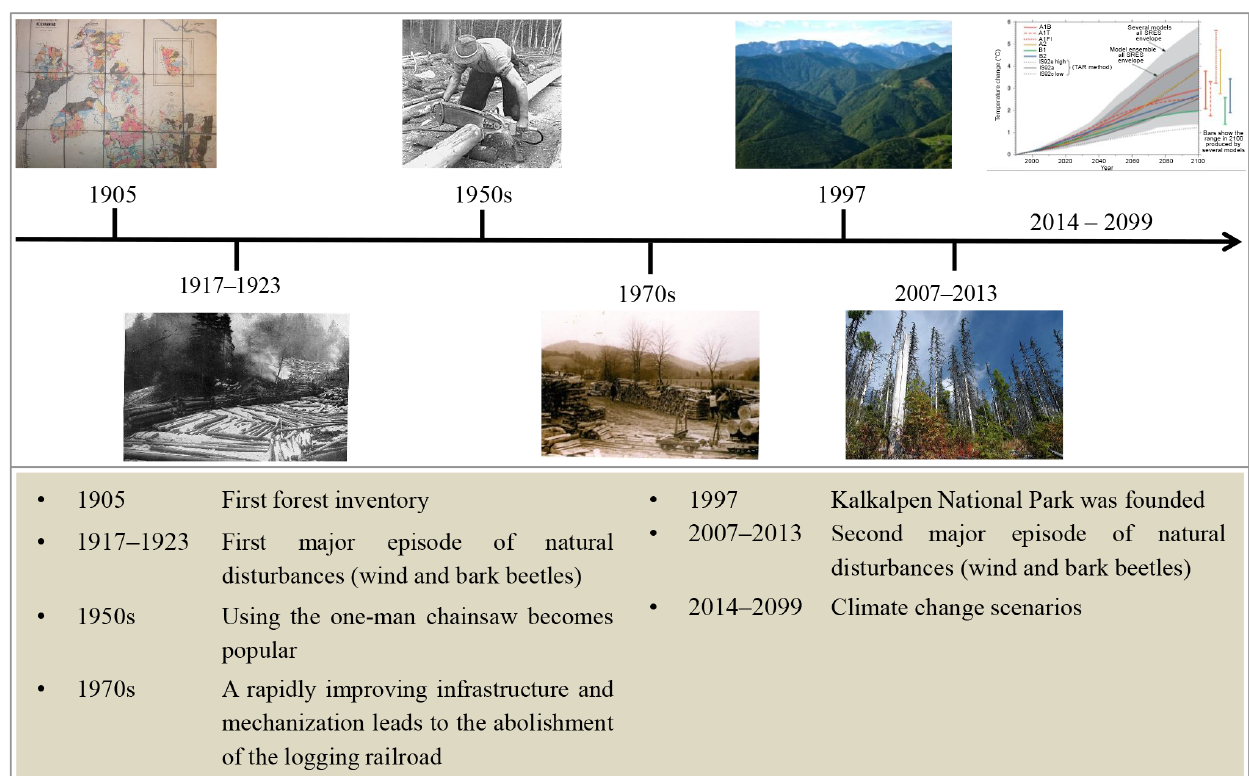
Figure 2. Timeline of historic events of relevance for the simulation of the study landscape. Image credits are as follows: 1905 and 1917– 1923, archives of the Austrian Federal Forests; 1950s, https://www.waldwissen.net/, last access: 20 September 2018; 1970s, https://atterwiki. at, last access: 20 September 2018; 1997, https://kalkalpen.at, last access: 20 September 2018; 2007–2013, photo taken by the authors of this study; 2014–2099, http://climate-scenarios.canada.ca, last access: 20 September